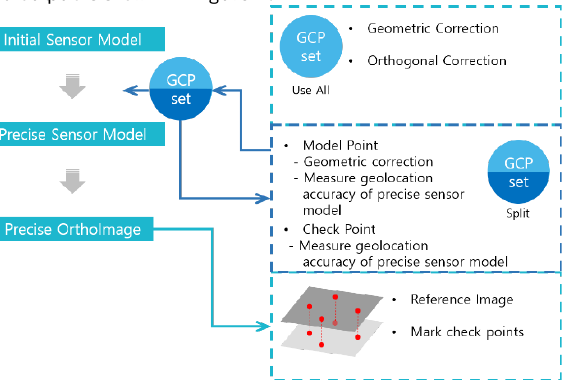
Table 3. Comparison of calibrating